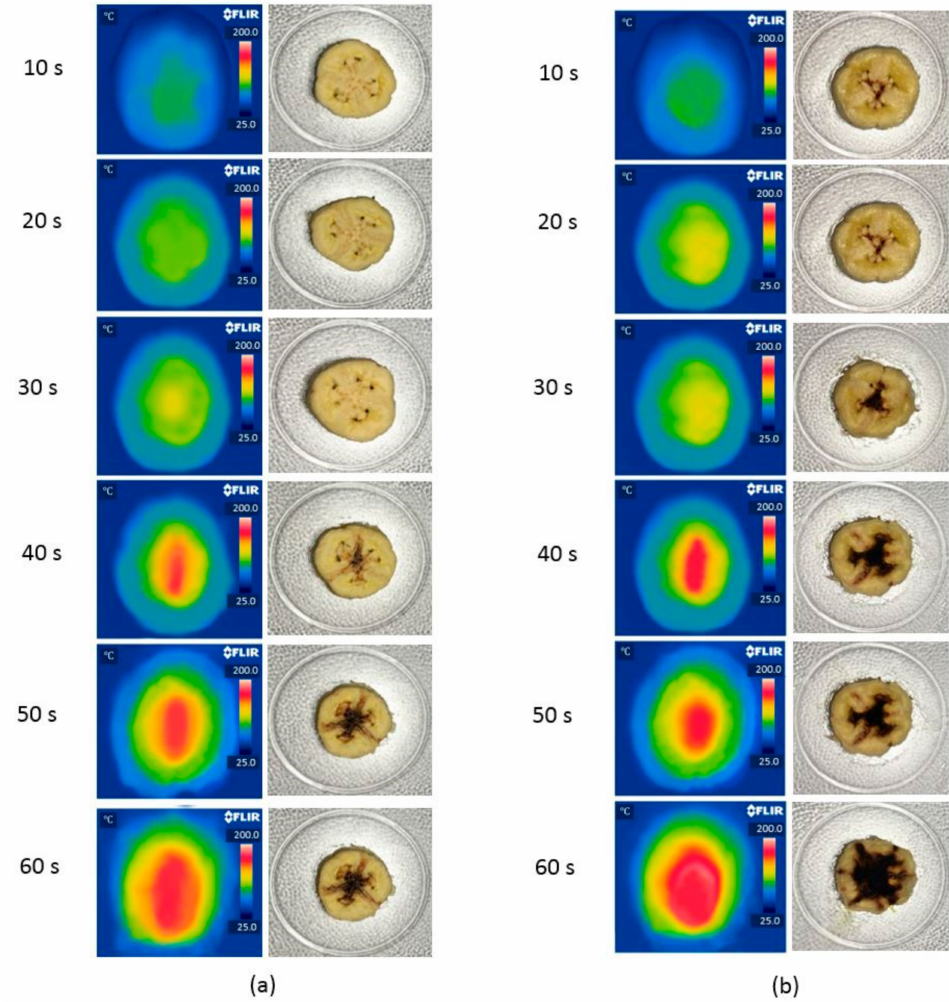
Figure 11. The infrared thermal images with photos of banana samples used in the experiments at di ff erent time intervals; ( a ) unripe bananas; ( b ) ripe